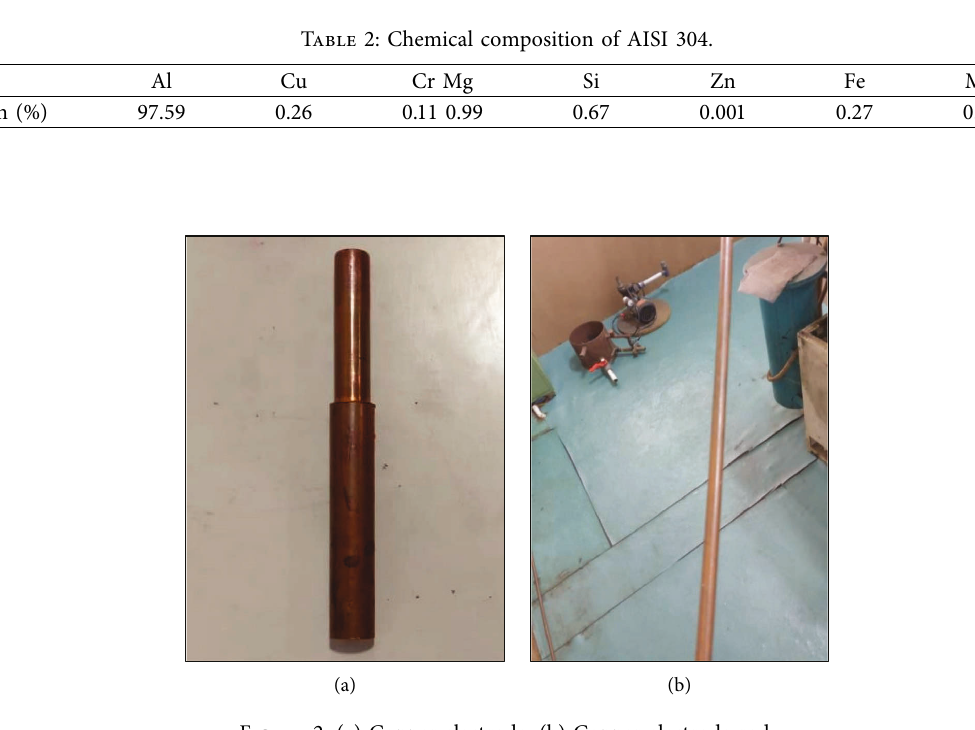
Figure 2: (a) Copper electrode. (b) Copper electrode